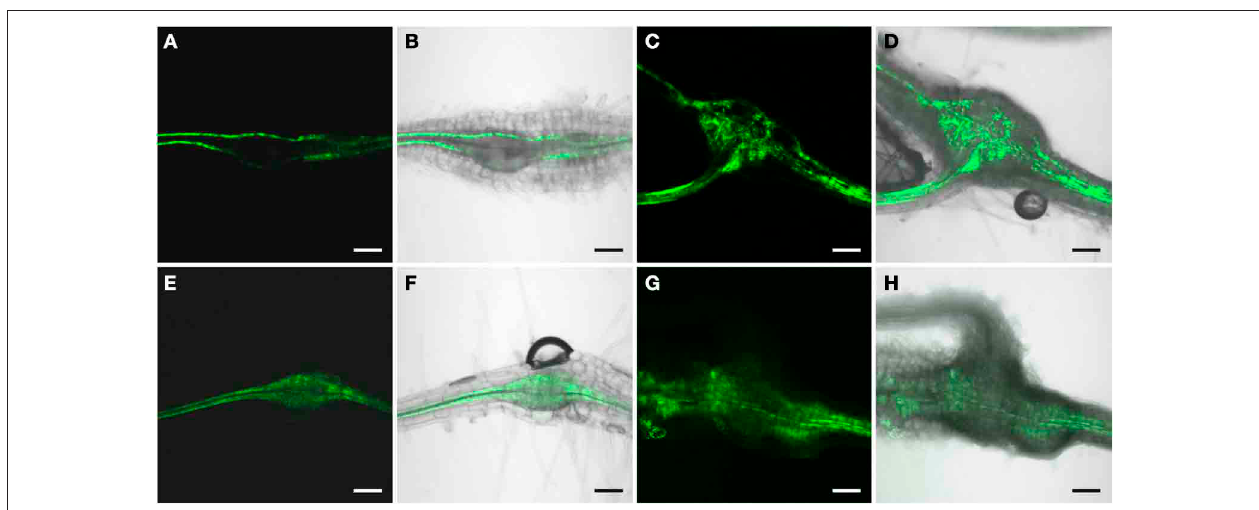
FIGURE 5 | Comparison of GFP fluorescence in root-knots of a M. incognita infected P SUC2 :GFP plant (A–D) and a P DR5 :ER - GFP plant (E–H) at 7dai (A and B, E and F) and 14dai (C and D, G and H). At 7dai, GFP-fluorescenceis limited to the sieve element/companion cell complex of